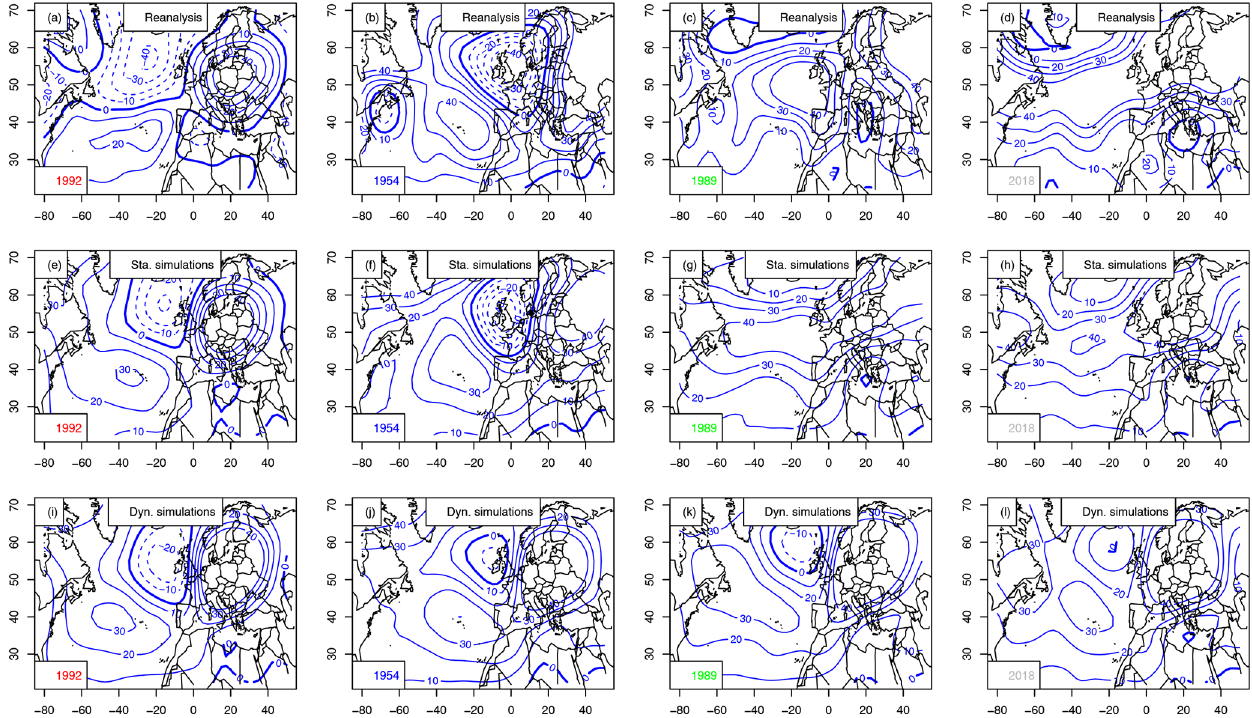
Figure A2. Z500 anomaly composites (in meters, with 10m increments) for the warmest summer in Berlin (1992), coolest (1954), median (1989) and 2018. The 0m isoline is indicated with a thick blue line. Negative anomalies are in dashed isolines. Horizontal axes are for longitudes in degrees east. Vertical axes are for latitudes in degrees north. Upper row (a–d) : mean Z500 from NCEP reanalyses. Center row (e–h) : static simulations. Bottom row (i–l) : dynamic